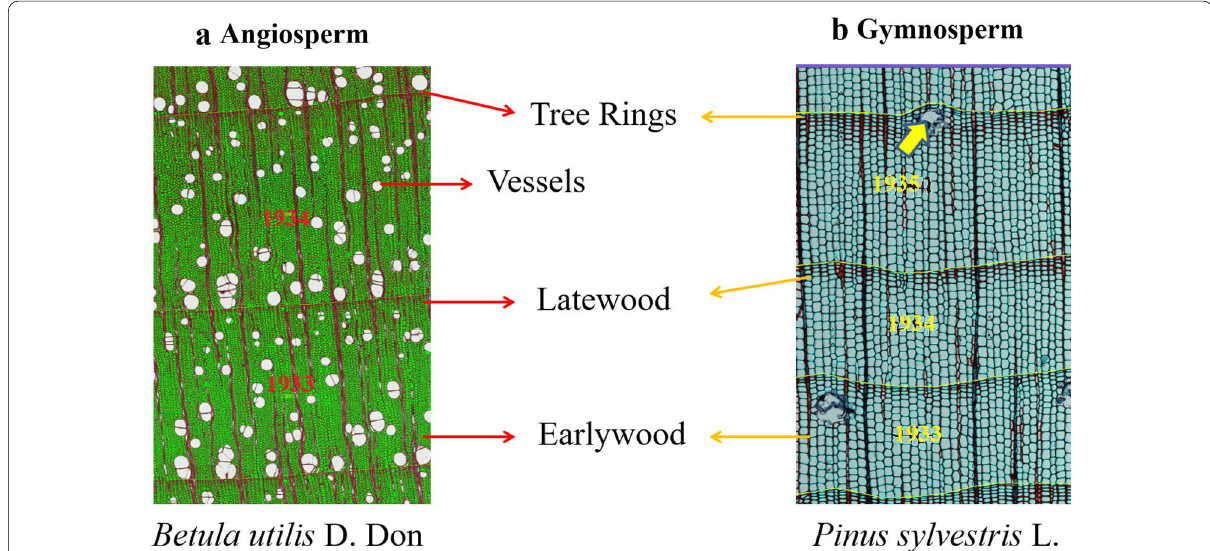
Fig. 1 Cut-out image showing xylem anatomical features (vessels, latewood, earlywood, tree rings) a Image of Betula utilis D. Don, Angiosperm b Image of Pinus sylvestris L., Gymnosperm. The arrow in b depicts a parenchyma cell of a resin